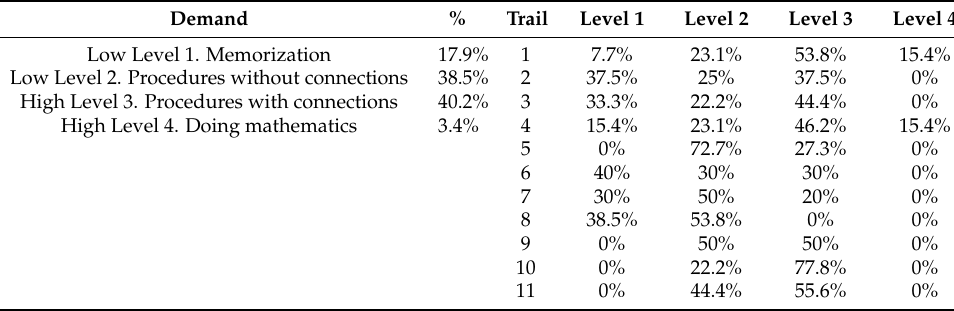
Table 6. Cognitive demand ( Demand ) of the tasks and breakdown for each trail.